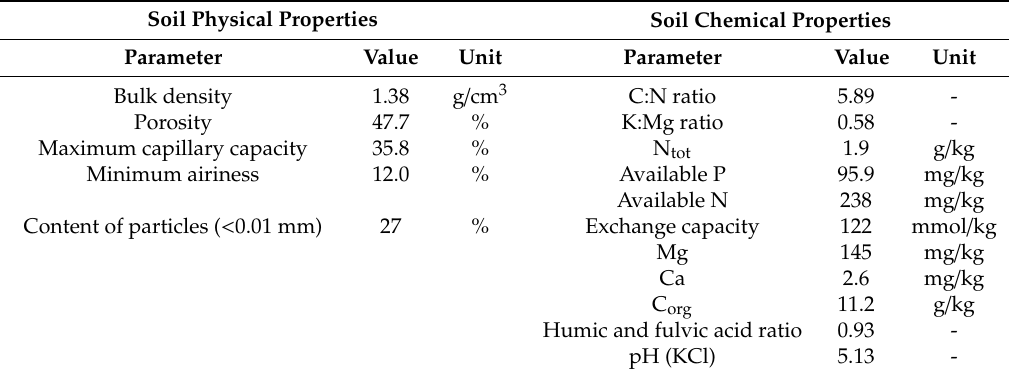
Table 1. Soil physical and chemical